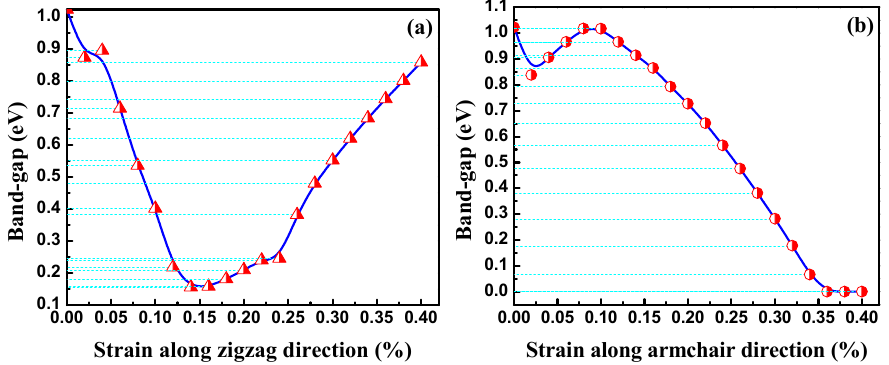
Figure 5. The variation in bandgaps for aPNTs and zPNTs with different radii.